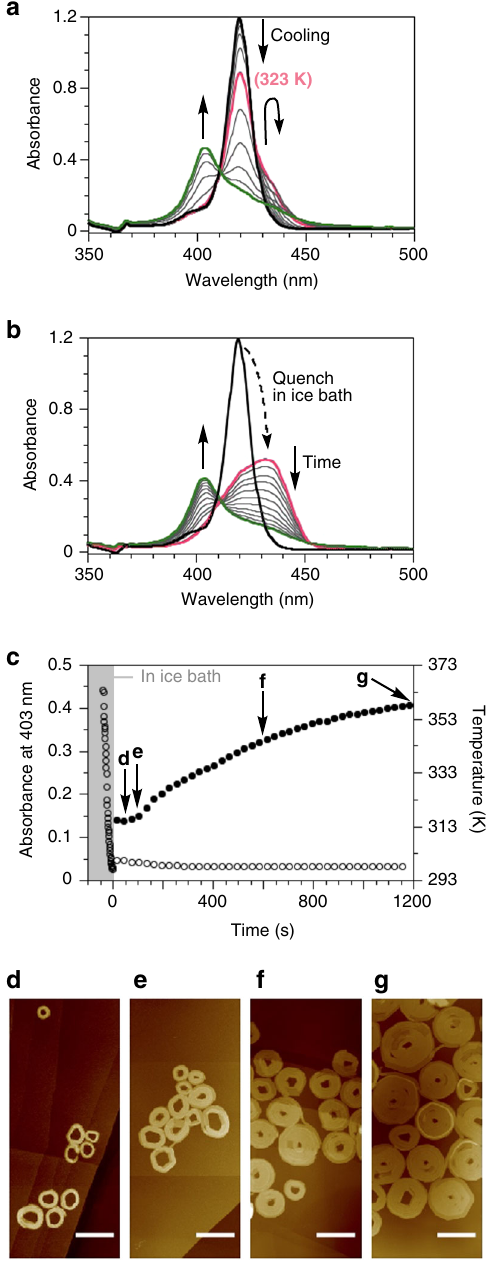
Fig. 3 Molecular self-assembly of 6FF. a Temperature-dependent changes in the absorption spectrum of a solution of 6FF in dodecane: [ 6FF ] = 12.5 μ M, 373 → 298K, − 5.0K/min. b Time-dependent changes in the spectrum of a solution of 6FF prepared by quenching a hot dodecane solution (373K, shown in black line) in an ice bath for 30s: [ 6FF ] = 12.5 μ M, measured at 298K. c Plots of the absorbance at 403nm ( fi lled circle) and the temperature of the solution (open circle) over time measured at 298K. d – g AFM images of the self-assembled 6FF observed during its propagation. Scalebar = 200nm. The AFM specimens were prepared from solution at the times indicated by the arrows in c : at d 50s, e 100s, f 600s, and g 9.5 × 10 − 8 M at 298 K, respectively (based on Supplementary Eq. S2). An increased thermal stability of supramolecular aggregates in the presence of an increased amount of fl uorinated side chains has also been observed in liquid crystals 18 . In addition